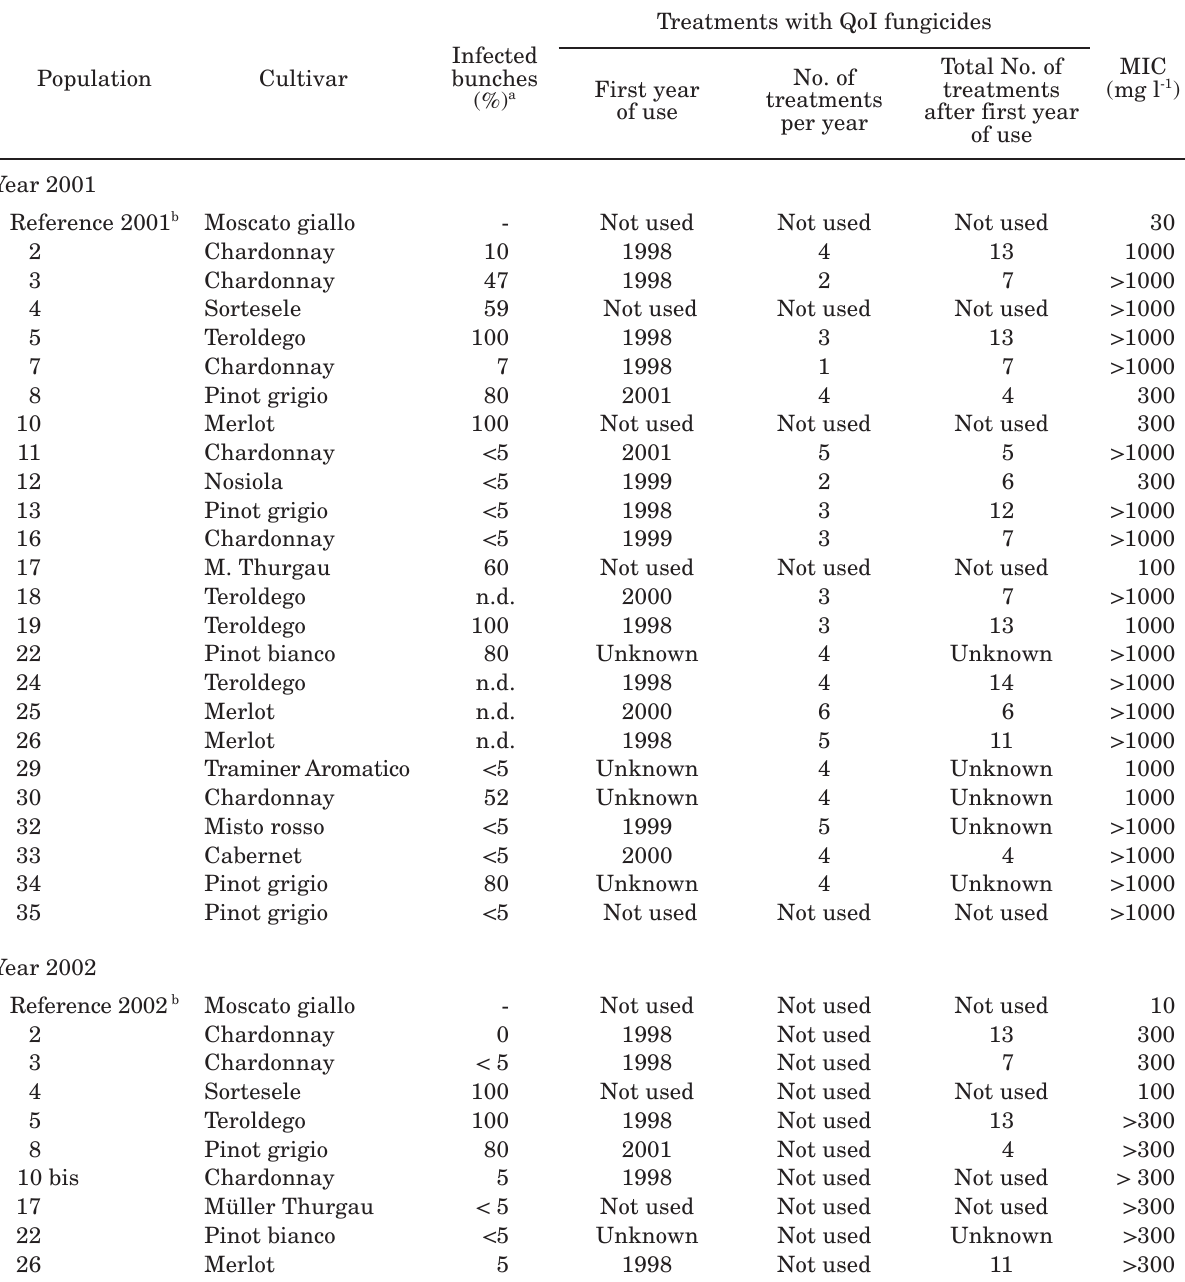
Table 2. Leaf disc test. Minimum inhibitory concentration (MIC) values, expressed as mg l -1 of azoxystrobin, in populations of P. viticola collected from vineyards in Trentino Alto Adige in 2001 and 2002. Population Cultivar bunches